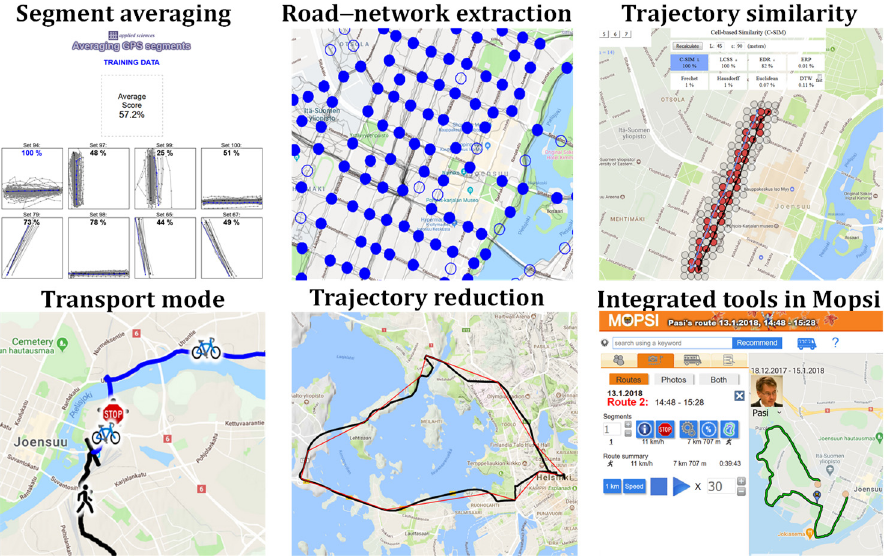
Figure 7. Summary of the Mopsi web tools available for others to test the segment averaging and related methods.